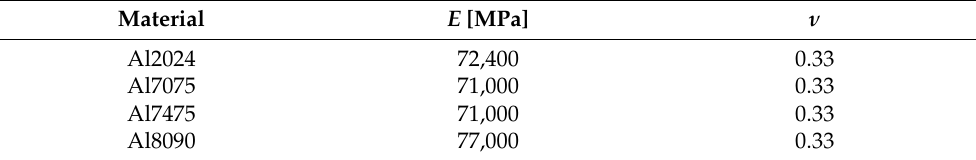
Table 2. Material Table 2. Material properties.